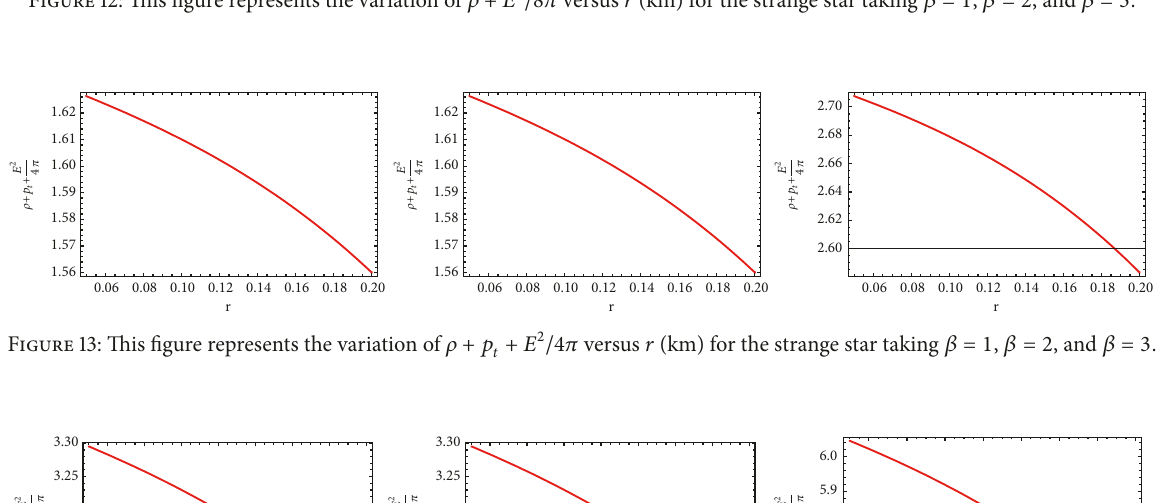
0.30 0.35 0.40 0.45 0.50 0.55 Figure 12: This figure represents the variation of 𝜌 + 𝐸 2 /8𝜋 versus 𝑟 (km) for the strange star taking 𝛽 = 1 , 𝛽 = 2 , and 𝛽 = 3 .